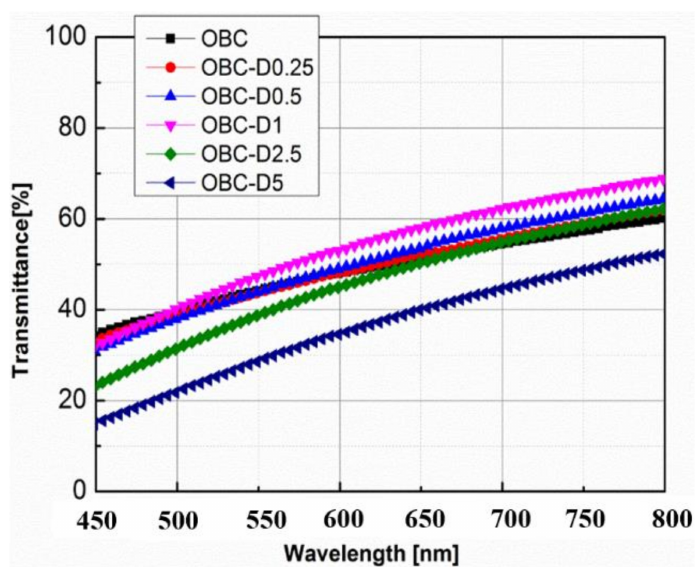
Figure 7. The optical properties of OBC/DMDBS mixtures containing different contents of